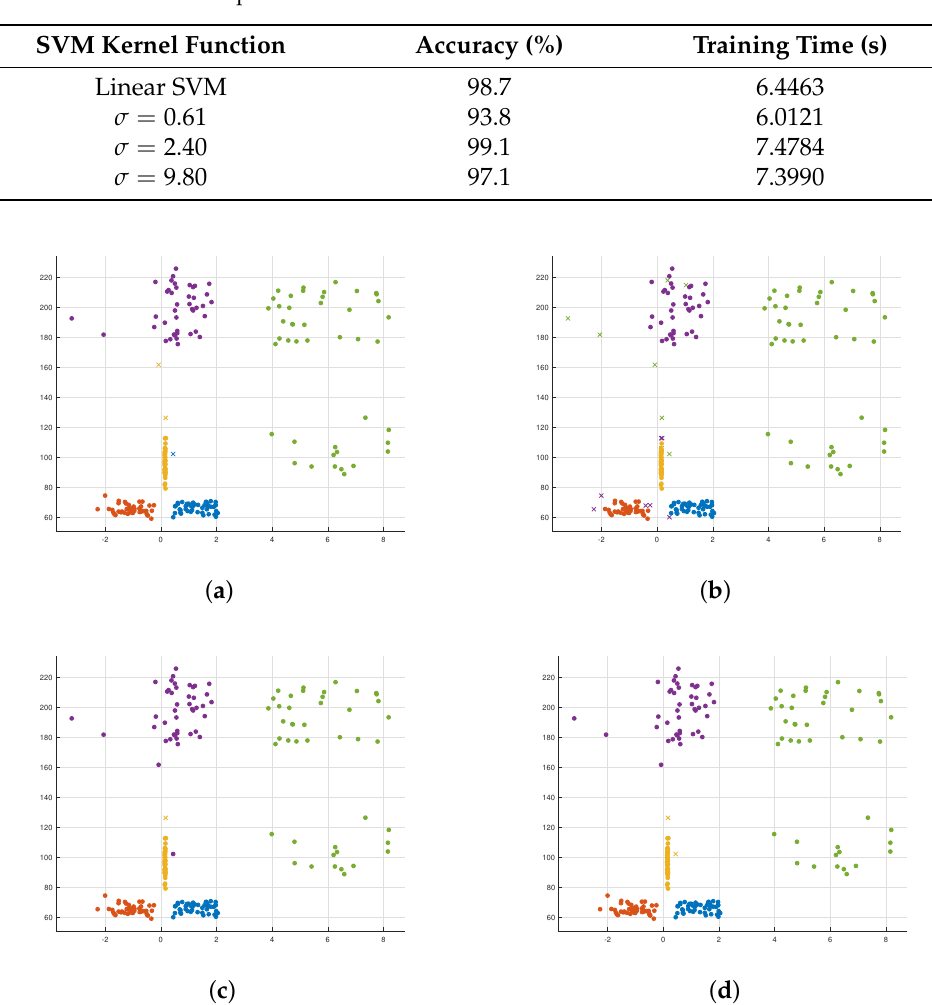
Figure 13. Classification models in SVM with a different kernel scale. ( a ) Linear SVM; ( b ) Gaussian σ = 0.61 (SVM); ( c ) Gaussian σ = 2.40 (SVM); ( d ) Gaussian σ = 9.80